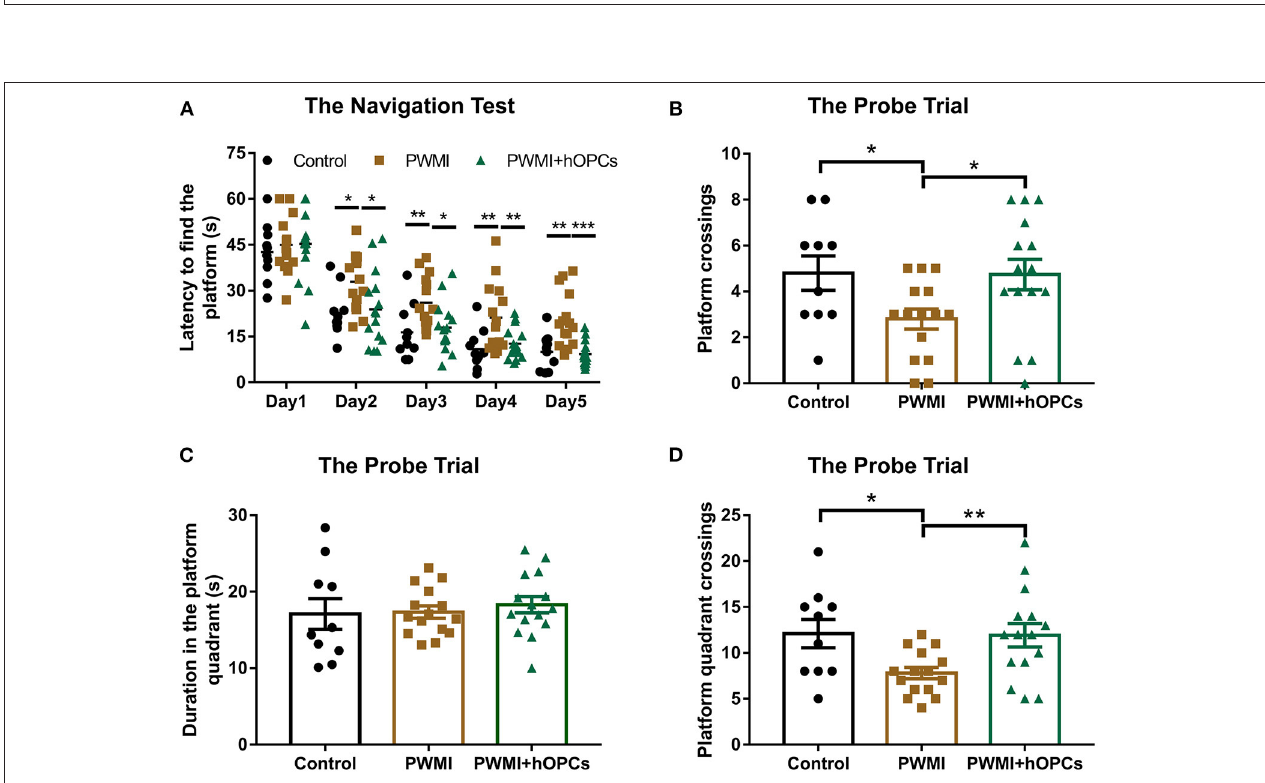
FIGURE 6 | Assessment of cognitive function. (A) In the navigation test, increased latency to find the platform of PWMI rats were reduced to a near-normal level after hOPCs-transplantation ( n = 10 for the control, n = 15 for PWMI and PWMI + hOPCs; repeated measures ANOVA, followed by LSD post-hoc test). (B–D) In the probe trial, platform crossings and platform quadrant crossings, but not duration in the platform quadrant, decreased in PWMI group and improved after hOPCs-transplantation ( n = 10 for the control, n = 15 for PWMI and PWMI + hOPCs; one-way ANOVA with LSD for multiple comparisons). Data are presented as mean ± SEM; * P < 0.05, ** P < 0.01, *** P <